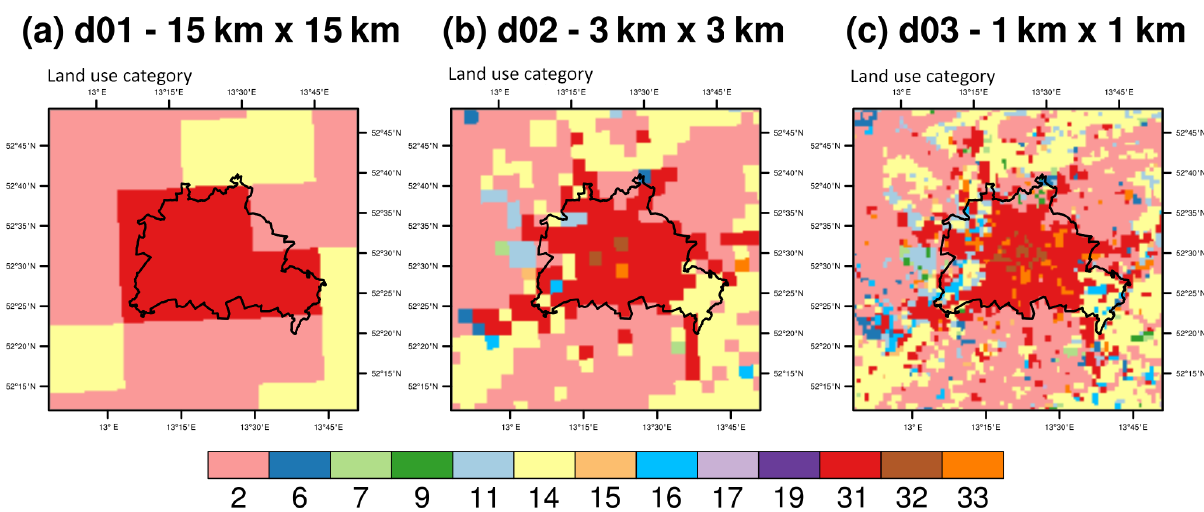
Figure 2. CORINE land use classes over Berlin mapped to USGS classes and interpolated to the WRF-Chem grids of (a) 15km, (b) 3km and (c) 1km horizontal resolutions. The classes are the following: 2 – dryland cropland and pasture, 6 – cropland/woodland mosaic, 7 – grassland, 9 – mixed shrubland/grassland, 11 – deciduous broadleaf forest, 14 – evergreen needle leaf forest, 15 – mixed forest, 16 – water bodies, 17 – herbaceous wetland, 19 – barren or sparsely vegetated, 31 – low intensity residential, 32 – high intensity residential, 33 –